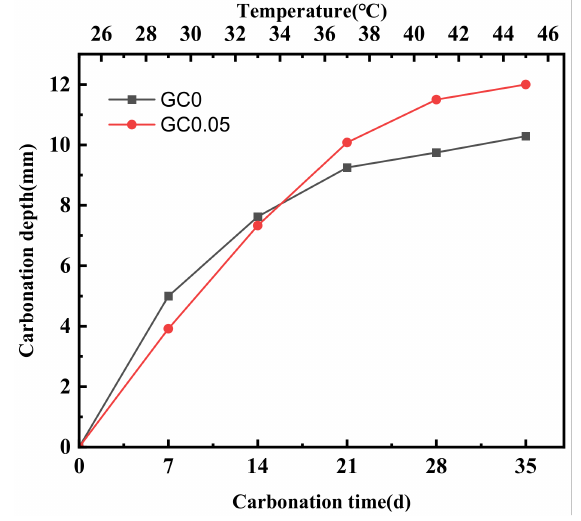
Figure 7. Relationship between concrete carbonation depth, time, and